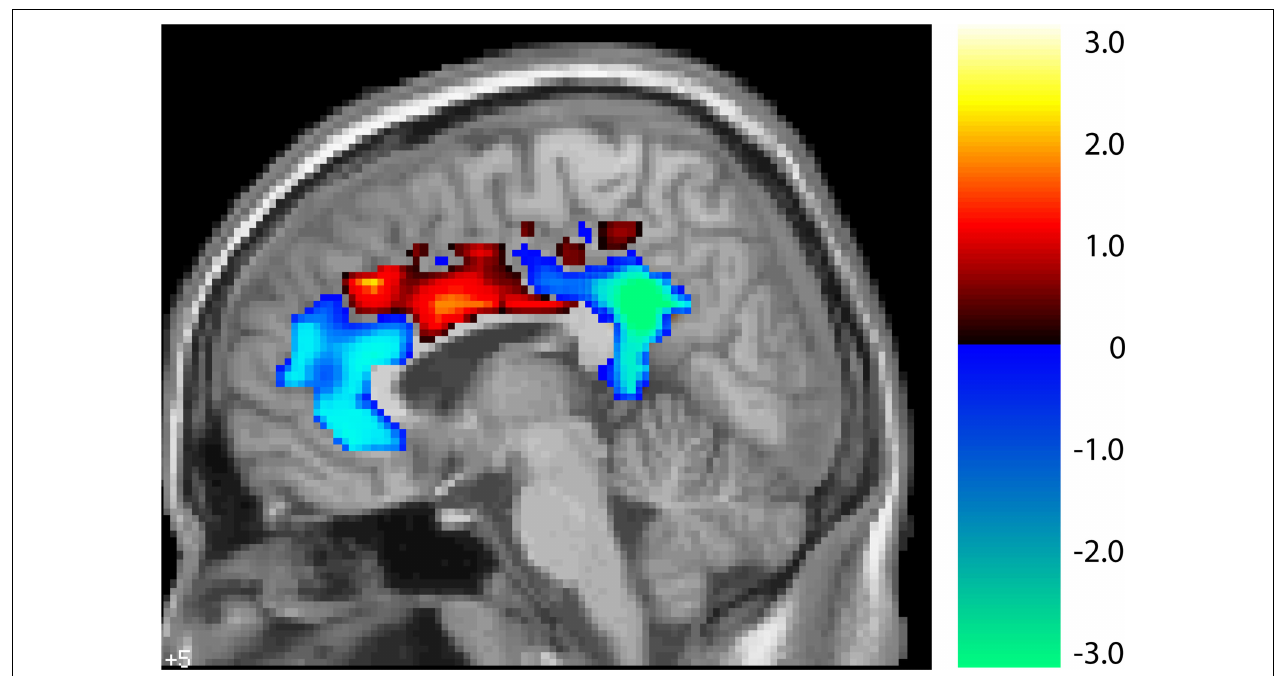
FIGURE 5 | T -map of age by task interaction along the cingulate (unthresholded). In blue areas, young show greater suppression for the harder coordinate task while old show no such task-related differential deactivation. In red areas there are no signifi cant differences between young and